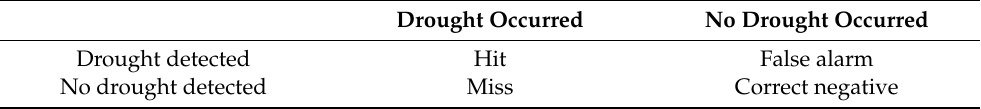
Table 2. Contingency table for drought detection. Drought Occurred No Drought Occurred Drought detected Hit False alarm No drought detected Miss Correct